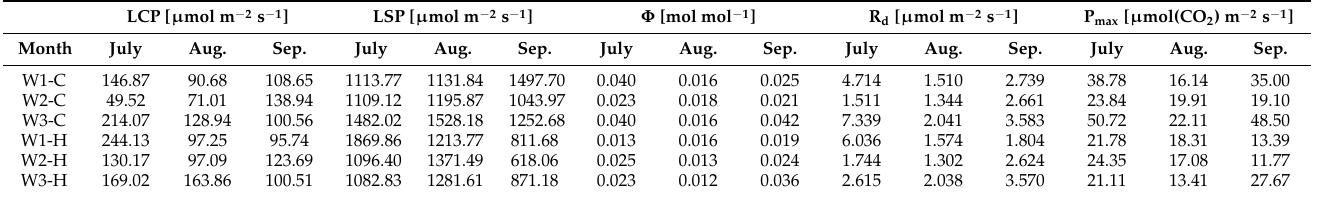
Table 1. The light compensation point (LCP), light saturation point (LSP), the apparent quantum yield of CO 2 assimilation ( Φ ), dark respiration rate (R d ) and light-saturated rate of CO 2 assimilation (P max ) of C and H under the low (W1), medium (W2) and high (W3) irrigation amounts.